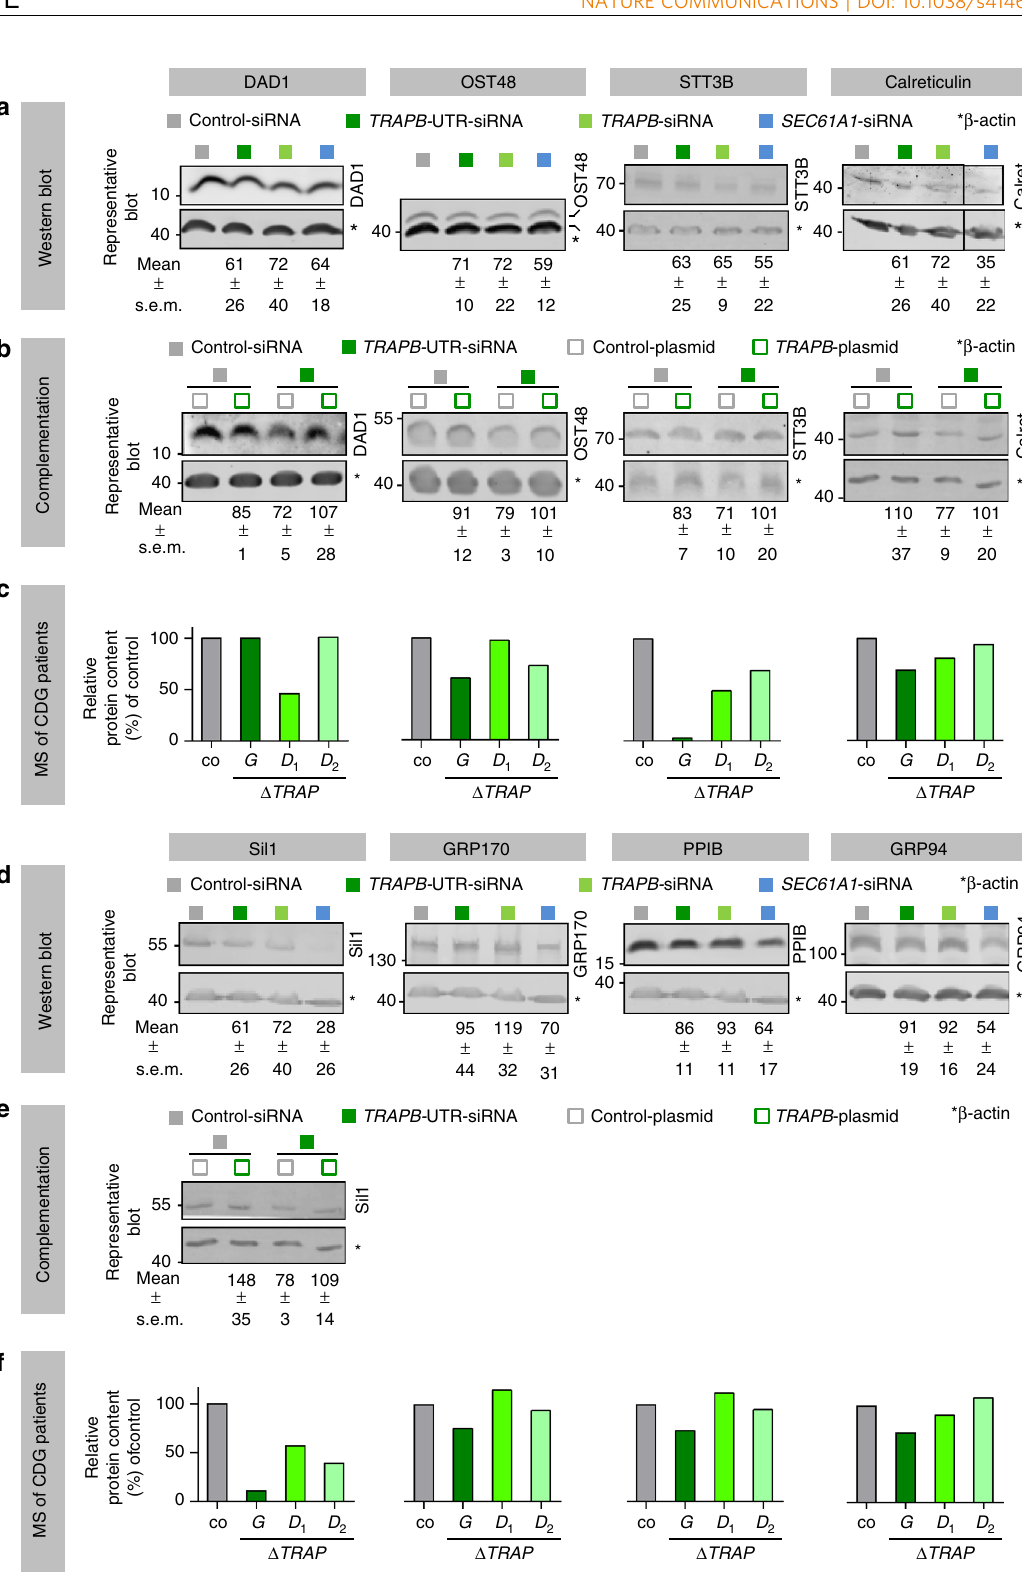
Fig. 4 Validation of TRAP clients by western blot and proteomic analysis of CDG patients. a , b , d , e HeLa cells were treated with two different TRAPB - targeting siRNAs, or SEC61A1- UTR-targeting siRNA, or control siRNA, and the consequences of complex depletion were analyzed by western blots for TRAP client candidates ( a ), which were deduced from the proteomic analysis, possible TRAP clients ( a , d ), and negative control proteins ( d ). Where indicated, silencing phenotypes were rescued by the indicated complementation and analyzed by western blots ( b , e ). Quantitative western blot data represent the mean protein levels (normalized to ß-actin) relative to control and standard errors of the mean (s.e.m.). Western blots refer to at least three independent experiments. c , f In addition, TRAP-de fi cient fi broblasts from CDG patients with mutations in TRAPG or TRAPD genes 27 were analyzed by quantitative